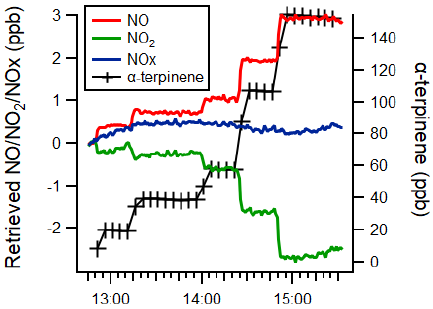
Figure 6. Time series of the α -terpinene mixing ratio (black) and measured NO (red), NO 2 (green) and NO x (blue) mixing ratios, as retrieved by monitor 1 (TE42i-TL), with a 1min time